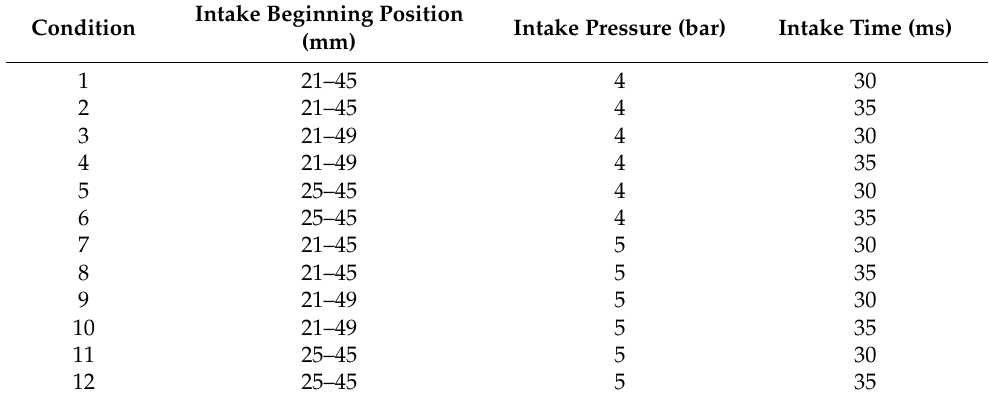
Table 3. The operating condition of experimental tests.